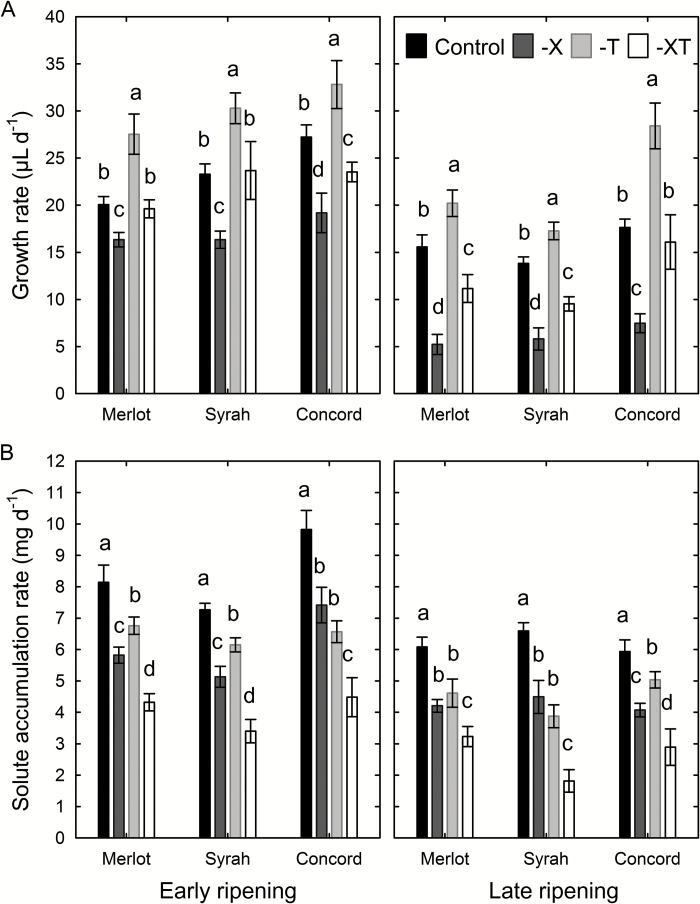
Effects of restricted xylem flow or berry transpiration on ripening of Merlot, Syrah, and Concord grapes. (A) Growth rate and (B) solute accumulation rate of berries from control clusters, clusters with restricted xylem flow (-X), restricted transpiration (-T), and the combination of both treatments (-XT). Treatments were in place for 14 d during both early and late ripening. Values are means±SE. Different letters indicate significant differences between means within genotypes at either early or late ripening (n=10, P<0.05).